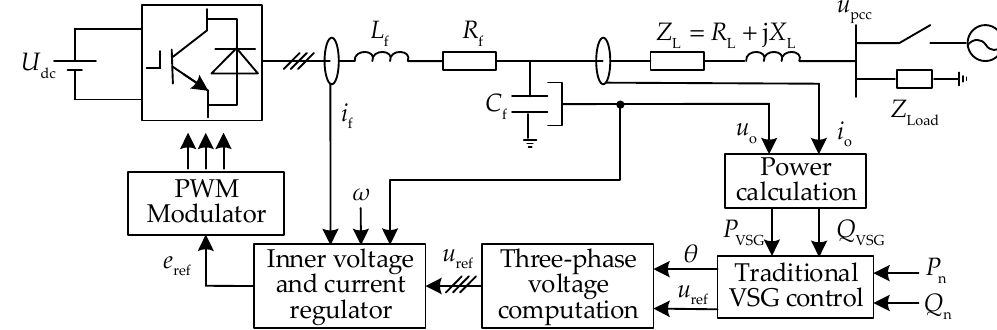
Figure 1. Integral control diagram of virtual synchronous generator (VSG)-controlled inverter.